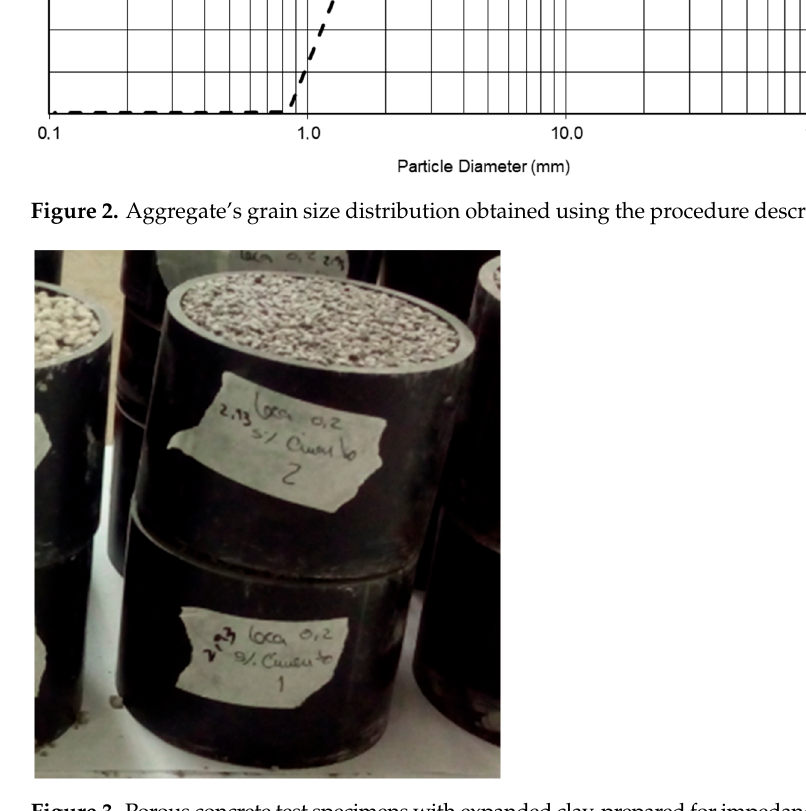
Figure 2. Aggregate’s grain size distribution obtained using the procedure described in EN 933-1 [37].